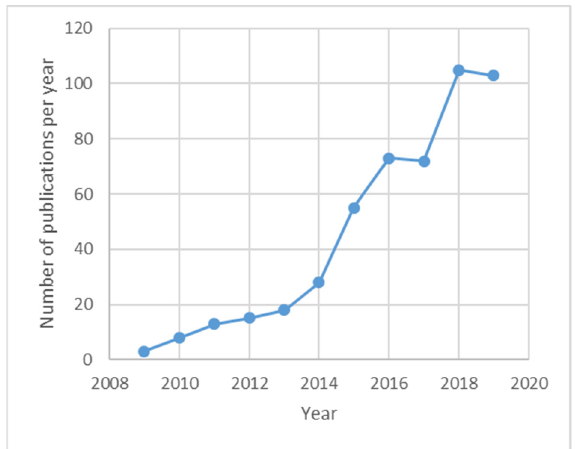
Figure 1. Evolution of the number of publications per year in the Optical Fiber Sensors field with the word “plasmonic” in their abstract, title or keywords. Source: